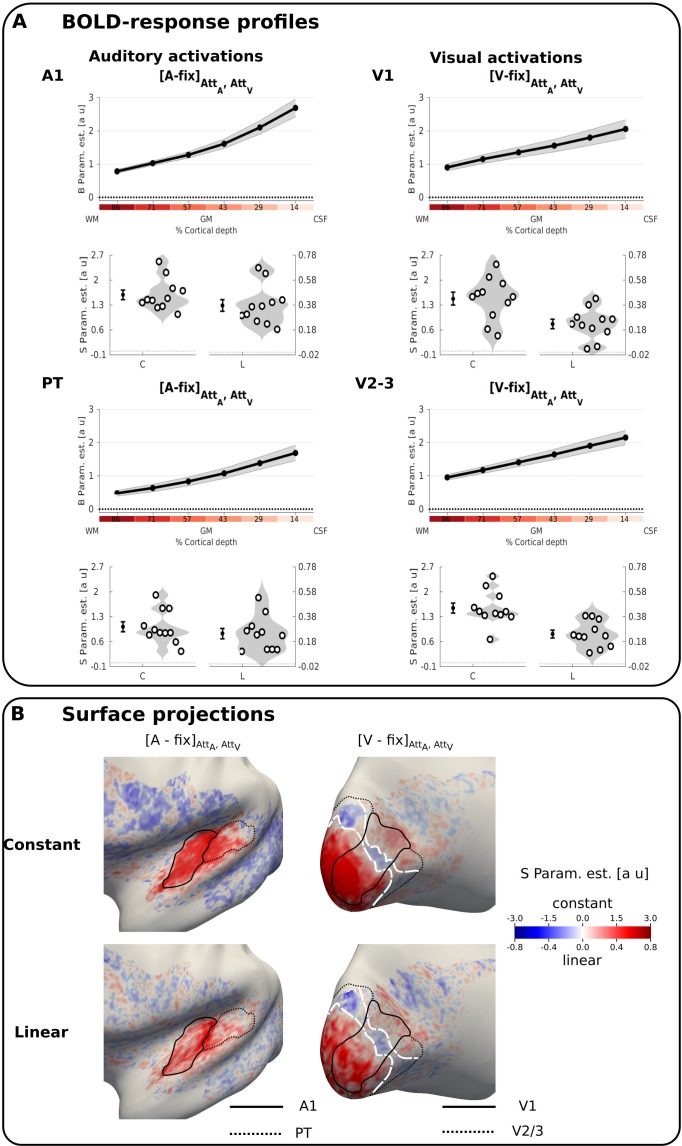
Auditory and visual activations.(A) BOLD response profiles: Row 1 and 3: The BOLD response (i.e. B parameters, across subjects’ mean ± SEM) for auditory and visual activations induced by looming stimuli averaged over auditory and visual attention in A1, PT, V1, V2/3 is shown as a function of percentage cortical depth. WM: white matter; GM: grey matter; CSF: cerebrospinal fluid. Percentage cortical depth is indicated by the small numbers and colour coded in red. Rows 2 and 4: Across subjects’ mean (± SEM) and violin plot of the participants’ shape parameter estimates that characterize the mean (C: constant) and linear increase (L: linear) of the laminar BOLD response profile. n = 11. (B) Surface projections: Across subject’ mean of the ‘constant’ (row i) and ‘linear’ increase (row ii) shape parameter estimates of the laminar BOLD response profile for auditory and visual looming stimuli (averaged over auditory and visual attention) are projected on an inflated group mean surface to show auditory and visual regions of the left hemisphere. A1 and V1 are delineated by black solid lines, PT and V2/3 by dashed lines. For visualization purposes only: i. borders between visual-induced activations and deactivations (white dashed lines) were defined based on visual inspection; ii. surface projections were smoothed (FWHM = 1.5 mm); iii. values are also presented for vertices for which data were not available from all subjects and which were therefore not included in our formal statistical analysis. Grey areas denote vertices with no available data for any subject.